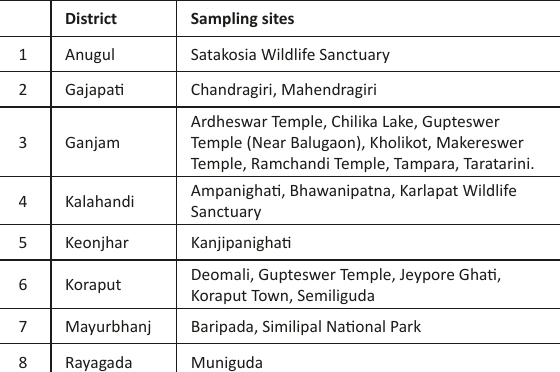
Table 1. Sampling sites during the present study.